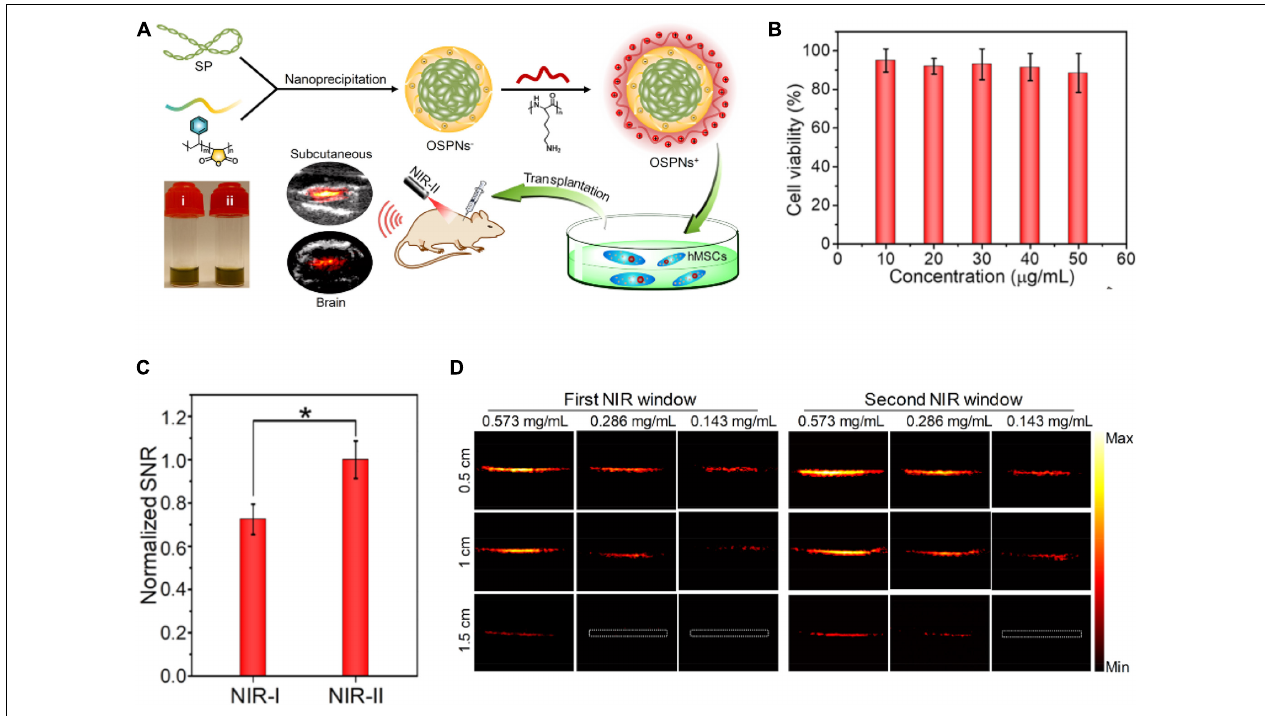
FIGURE 7 | (A) Illustration of the preparation procedure of OSPNs + and the photoacoustic labeling of human MSCs after transplantation. (B) The MTT assay of human MSCs treated by OSPNs + for 12 h under various concentrations. (C) Normalized PA SNR of OSPNs + -labeled hMSCs implanted into mice brain under NIR-I (860 nm) or NIR-II (1,064 nm) light excitation (* p < 0.05). (D) PA imaging of aqueous OSPNs + solutions (0.573, 0.286, and 0.143 mg/ml) (adapted from Yin et al.,